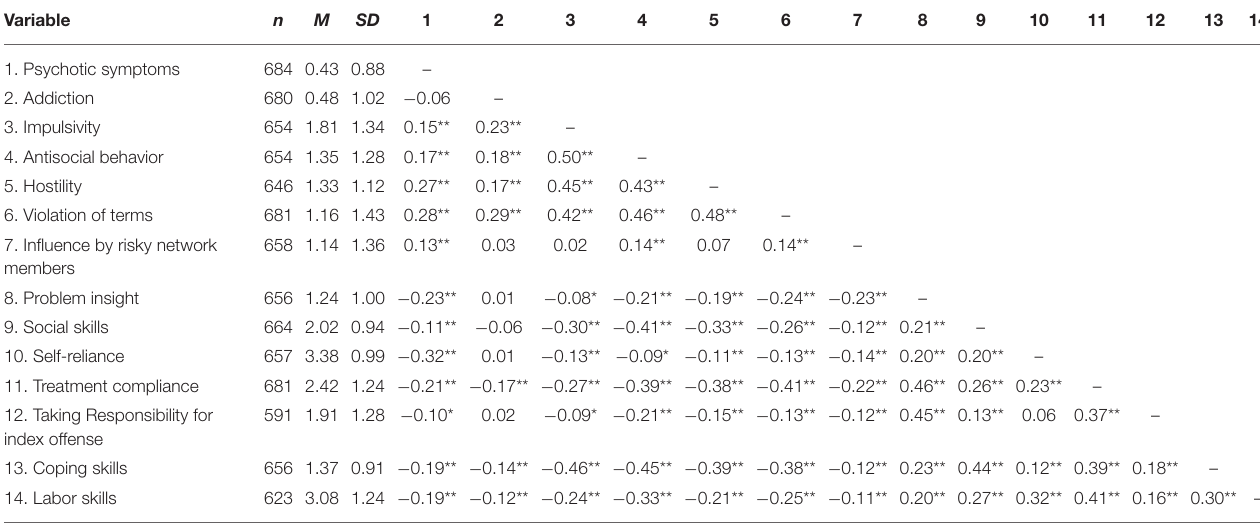
TABLE 2 | Descriptive statistics and correlations for clinical risk and protective factors. Variable